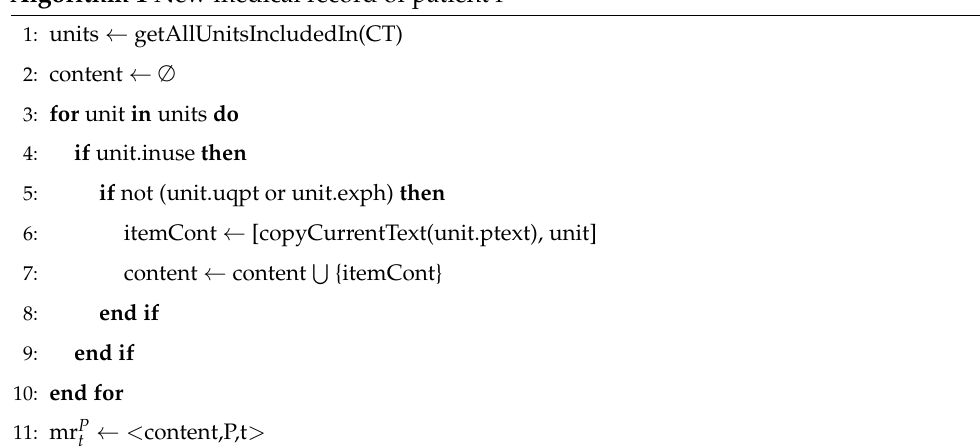
Algorithm 1 New medical record of patient P